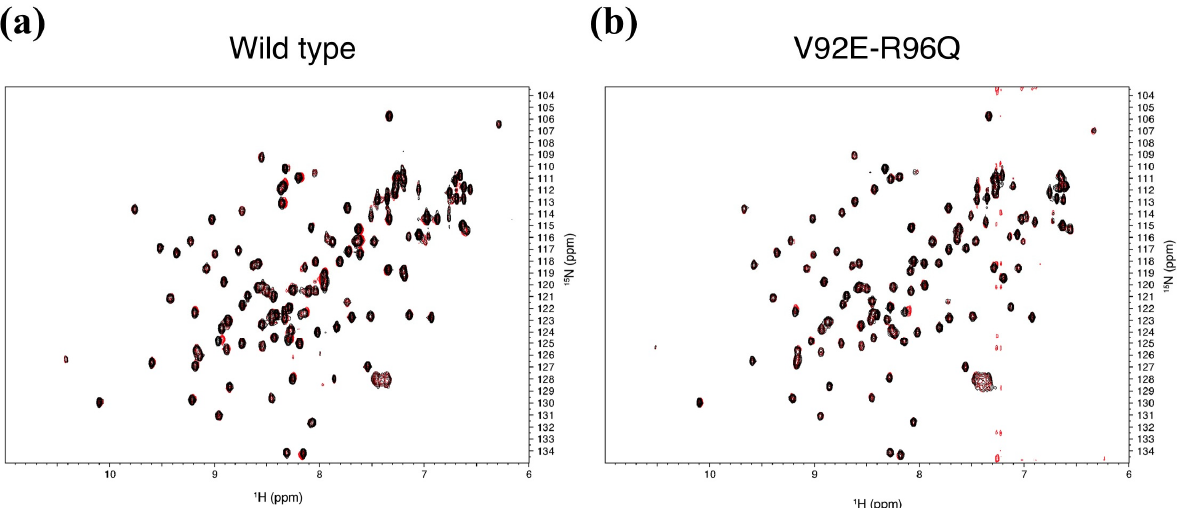
Figure 5. Identification of the key residues of the mZO-1 PDZ1 domain responsible for DIF binding. Overlaid spectra derived from wild type ( a ) and the V92E-R96Q mutant ( b ) of the mZO-1 PDZ1 domain with (red) and without (black)